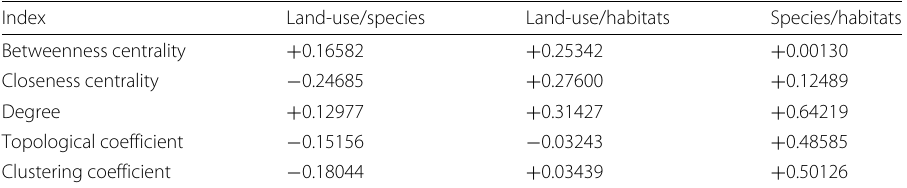
Table 8 Spearman correlation of various complex network indices, between pairs of similarity-based graphs